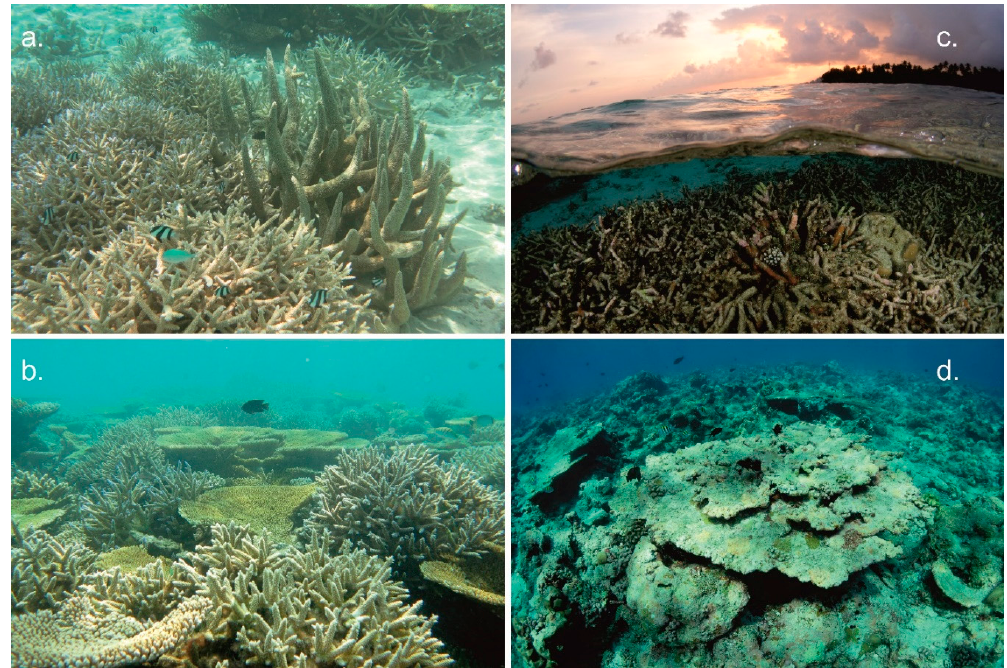
Figure 10. ( a , b ) Underwater pictures of branching and tabular Acropora spp. colonies taken before bleaching (February 2016) on the reef flat of Magoodhoo. ( c , d ) Dead branching and tabular corals still